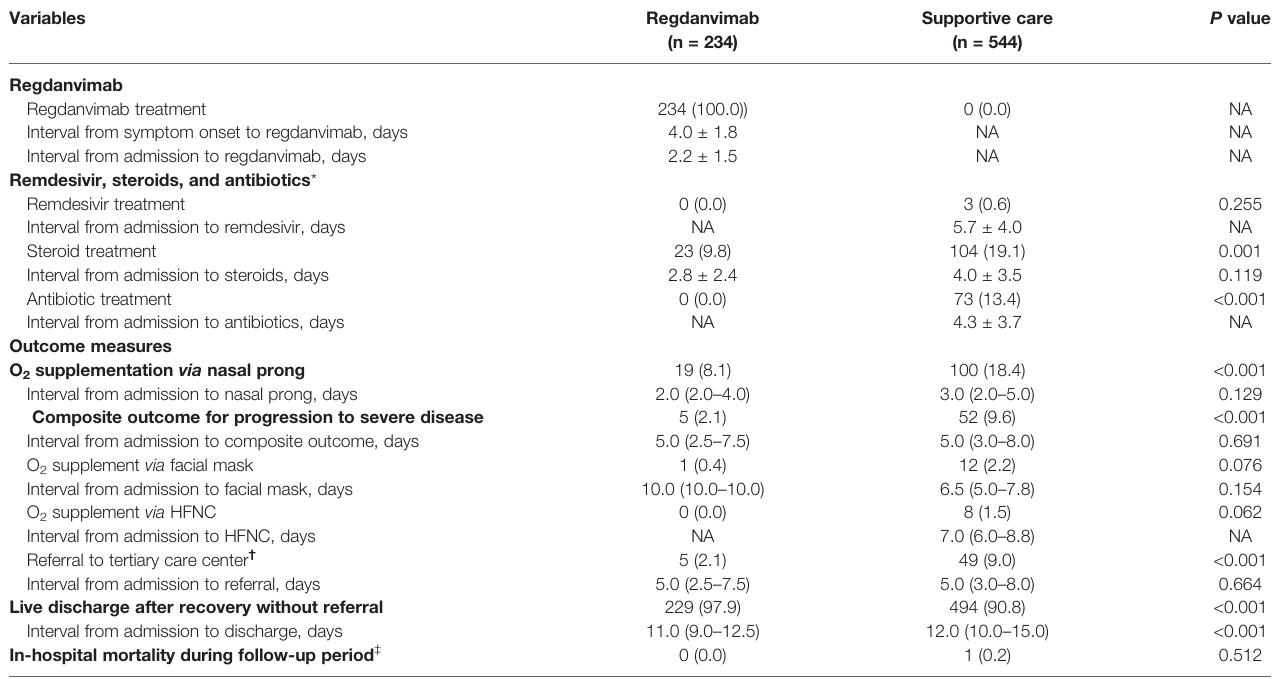
TABLE 2 | Treatment and outcomes of the regdanvimab and supportive care groups. Variables